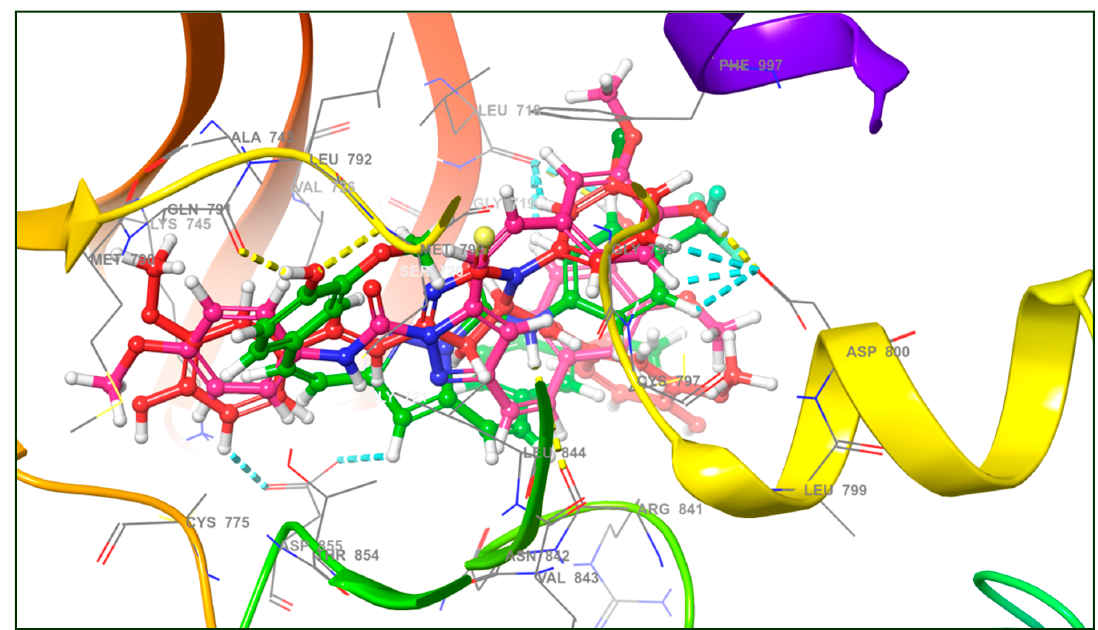
Figure 2. The binding mode of curcumin analogs ( 3a – c ) and various types of interactions (yellow dotted line ( --- ) showing H-bond and sky blue dotted line ( --- ) showing π – π stacking) with amino acid residues in docking studies against the active site of EGFR.